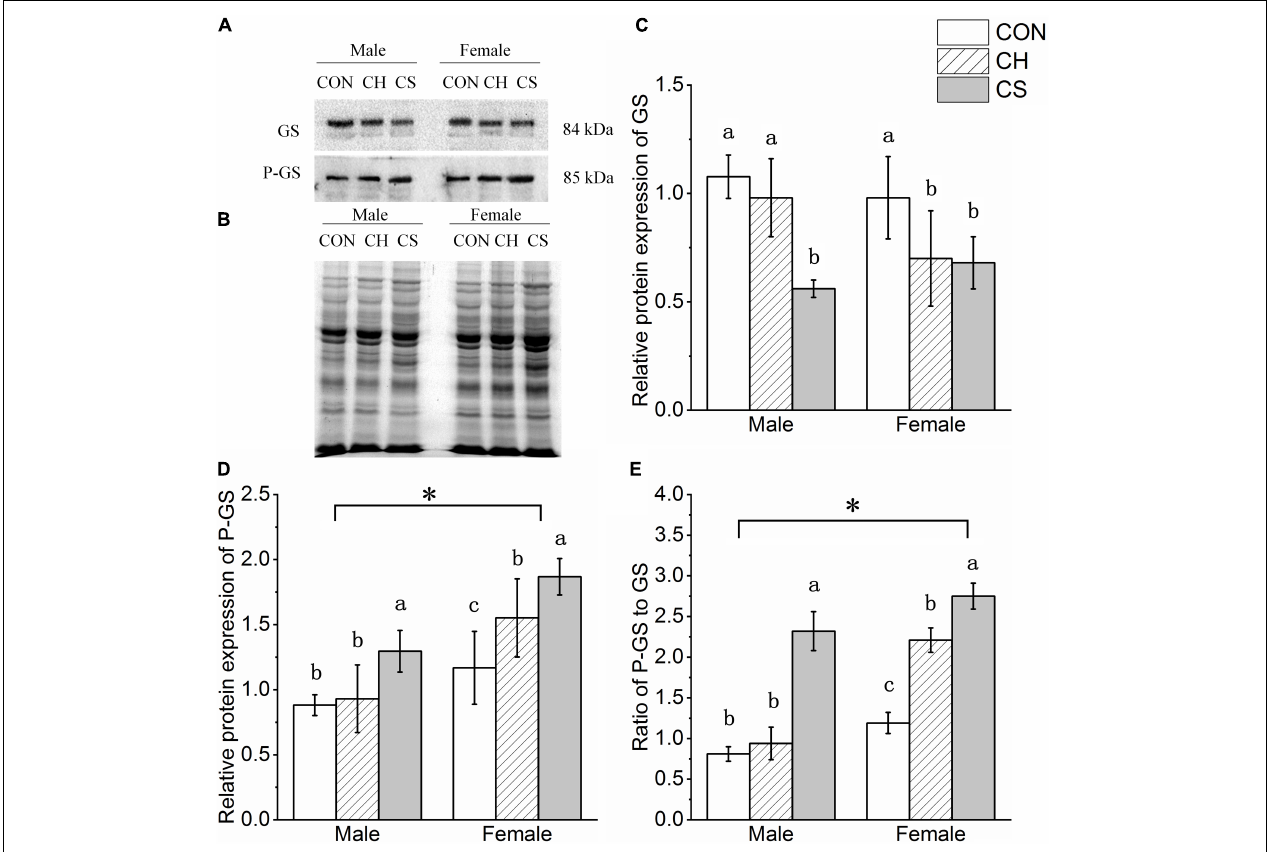
FIGURE 5 | Changes in protein expression levels of glycogen synthesis-related factors in cardiac muscle of Brandt’s voles. (A) Representative immunoblots of GS and P-GS in cardiac muscle. (B) Representative polyacrylamide gel of total protein. (C) Relative protein expression of GS. (D) Relative protein expression of P-GS. (E) Ratio of P-GS to GS. Values are mean ± SD. n = 8. CON, control group; CH, cool huddling group; CS, cool separated group. Different letters identify statistically significant differences among temperature treatment groups ( P < 0.05). ∗ P < 0.05 significant differences between males and